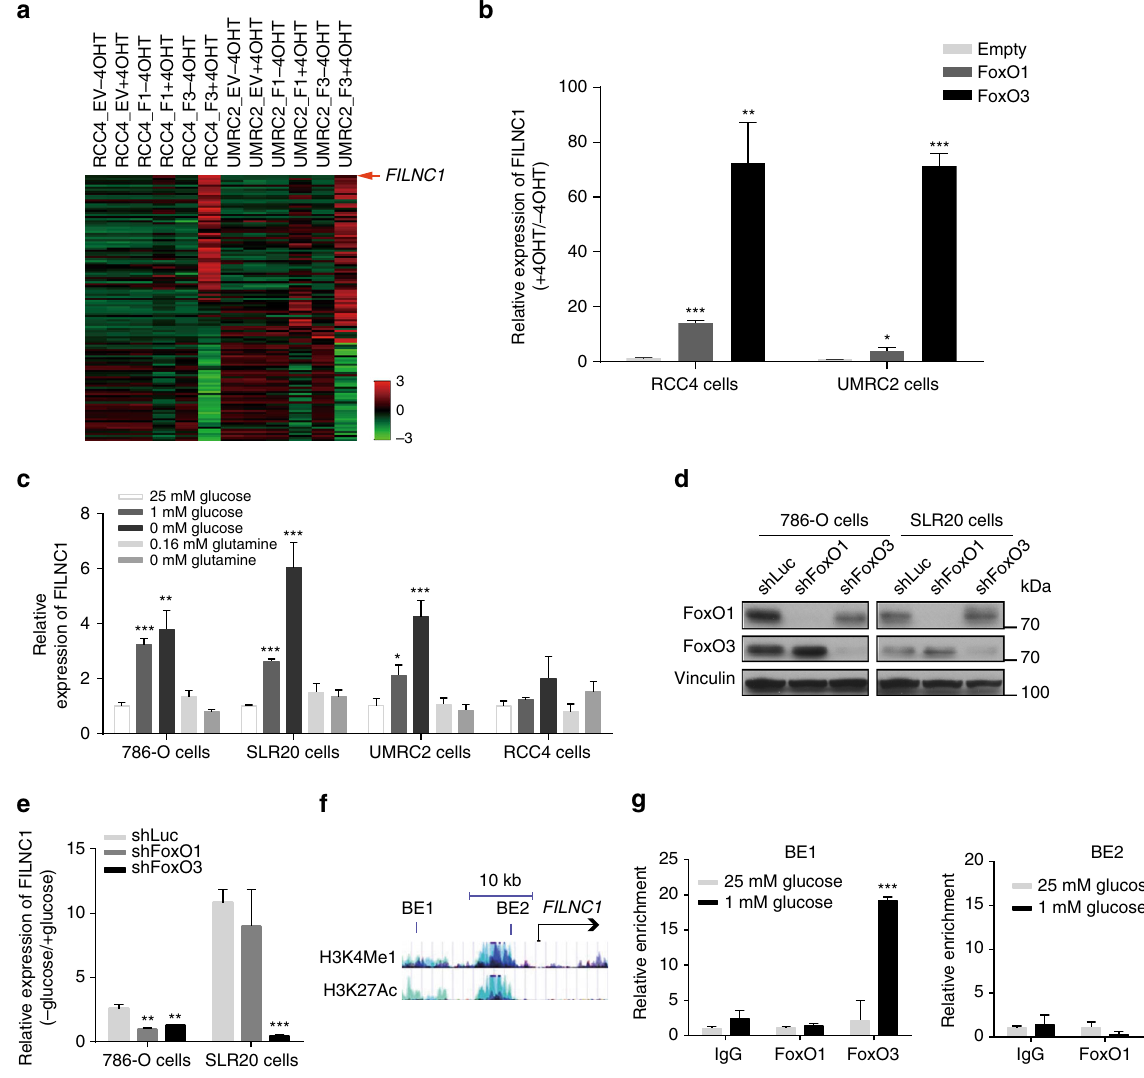
Fig. 1 FILNC1 is induced by FoxO activation and glucose starvation. a Heatmap of the most differentially regulated lncRNAs from FoxO RCC transcriptome data sets. In each of the two RCC cell lines (RCC4, UMRC2), we generated three stable cell lines: empty vector ( EV ), FoxO1(TA)ERT2 (F1), and FoxO3(TA) ERT2 (F3). 4OHT treatment (+4OHT), but not vehicle treatment ( − 4OHT), will translocate FoxO1 or FoxO3 from cytoplasm to nucleus and thus activate FoxO-mediated transcription. b Bar graph shows the relative expression changes of FILNC1 by real-time PCR in the indicated cell lines with or without 4OHT treatment for 24 h. c Bar graph shows the relative expression changes of FILNC1 by real-time PCR in renal cancer cells under different culture conditions for 24 h as indicated. d Renal cancer cells were infected with different shRNAs, and then subjected to western blotting analysis to examine FoxO1 and FoxO3 expression. e Renal cancer cells infected with different shRNAs were cultured in 25 or 1 mM glucose-containing medium for 24 h, and then subjected to real-time PCR analysis to measure FILNC1 expression. Bar graph shows the relative fold change ( − Glucose/+Glucose) of FILNC1 expression in different cells as indicated. f The screenshot shows genome browser tracks for FoxO-binding elements (BE1 and BE2), H3K4Me1 and H3K27Ac pro fi le upstream of FILNC1 gene. g SLR20 cells were cultured in 25 or 1 mM glucose-containing medium for 24 h, and then subjected to ChIP analysis to detect FoxO1/3 binding to FoxO-binding elements identi fi ed in FILNC1 promoter. Bar graph shows the relative enrichment determined by real- time PCR following ChIP analysis using IgG (control), FoxO1, and FoxO3 antibodies. Values represent mean ± s.d. from three independent experiments, two-tailed Student ’ s t -test. * P < 0.05; ** P < 0.01; *** P < 0.001 energy stress inducers on FILNC1 expression. Our analysis correlated with the H3K4me1 and H3K27Ac chromatin mod- revealed that treatment of AMP mimetic 5-aminoimidizole-4- i fi cation status pro fi led by the ENCODE project 21 (Fig. 1f). Chromatin immunoprecipitation (ChIP) assay showed that carboxamide riboside (AICAR) or the glucose analog 2-deoxy- glucose starvation promoted FoxO3 binding to FoxO BE1, glucose (2DG) also induced FILNC1 expression (Supplementary suggesting that FILNC1 is a direct transcriptional target of FoxO Fig. 2). Importantly, FoxO (particularly FoxO3 ) de fi ciency by (Fig. 1g). Taken together, our results revealed that FILNC1 shRNA-mediated knockdown attenuated glucose starvation- expression can be induced by glucose starvation at least partially induced FILNC1 expression (Fig. 1d, e). Analysis of FoxO- through FoxO (mainly FoxO3) transcription factors, well aligned binding element (BE) upstream of FILNC1 transcription start site with our previous results on an important role of FoxOs in revealed that there were two putative FoxO BEs located within the mediating energy stress response 20 . transcription regulatory regions of FILNC1 gene, which also NATURE COMMUNICATIONS | 8: 783 | DOI: 10.1038/s41467-017-00902-z |